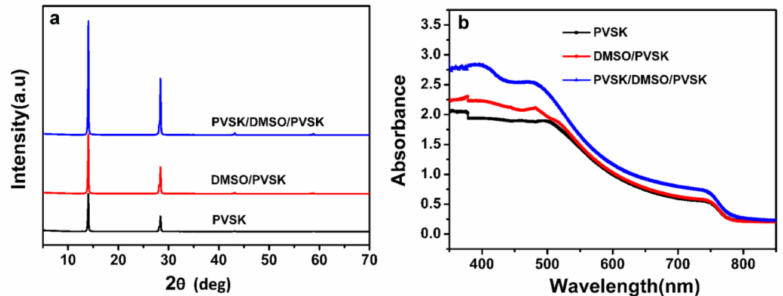
Figure 4. XRD patterns ( a ) and UV absorption spectra ( b ) of perovskite film on a pristine PEDOT:PSS film and PEDOT:PSS films rinsed with DMSO and the pre-deposited perovskite layer rinsed with